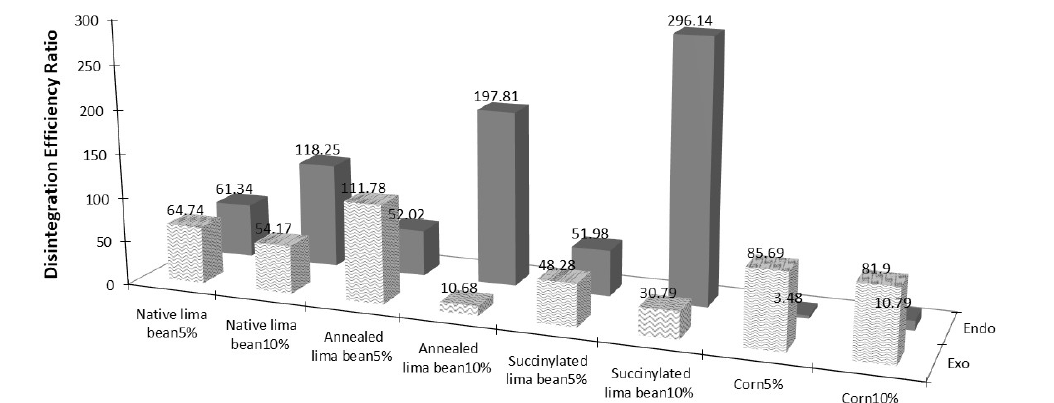
FIGURE 4 - Disintegration Efficiency Ratios of Disintegrants Incorporated Exo-granularly and